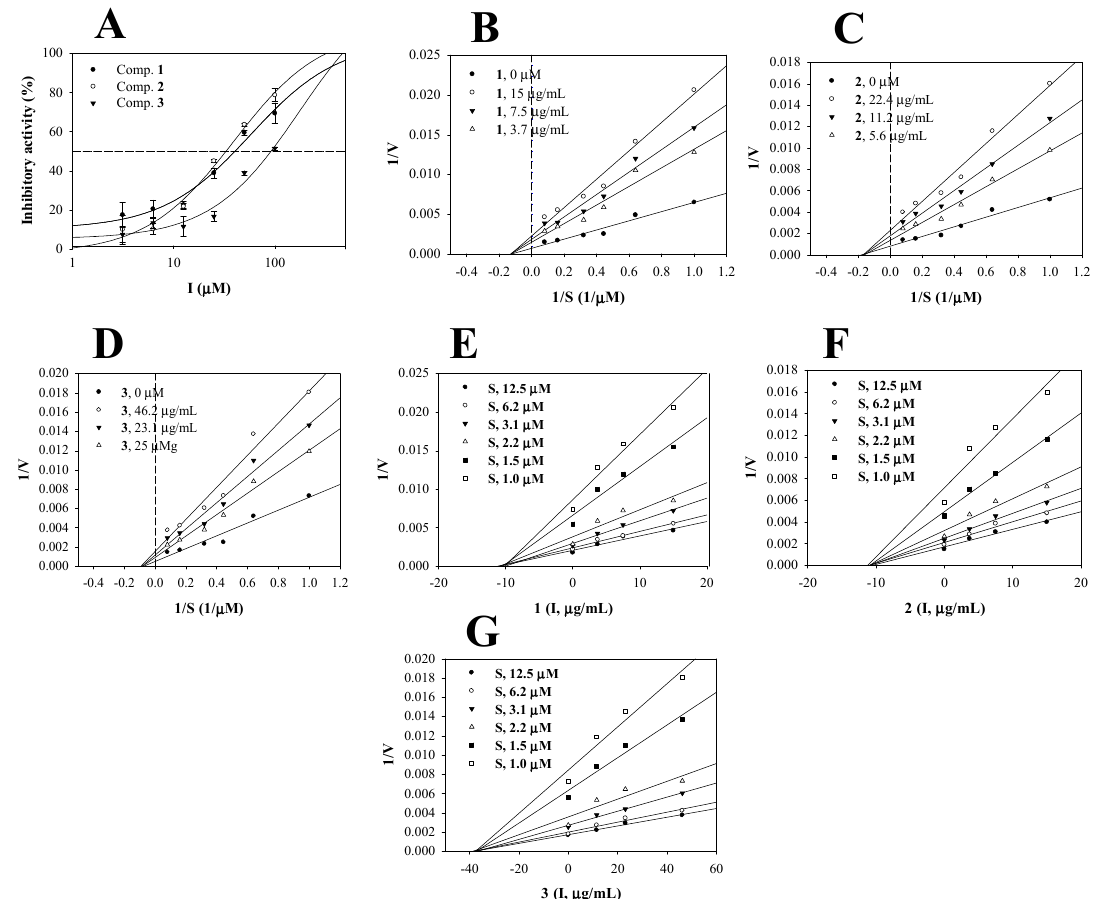
Figure 2. Inhibitory activities of inhibitors 1 – 3 on sEH ( A ). Lineweaver–Burk plots ( B , D ) and Dixon plots ( E , F ) for the inhibition of sEH by 1 – 3 .